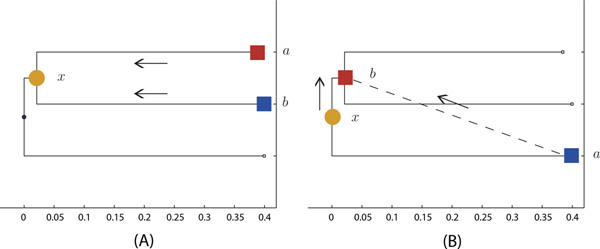
(A) The forward particle passing procedure. The particles of two duplicates a and b are passed to infer their ancestral particle x. (B) The backward particle passing procedure. The ancestral particle x and particle of one duplicate a are passed to infer the other duplicate b.